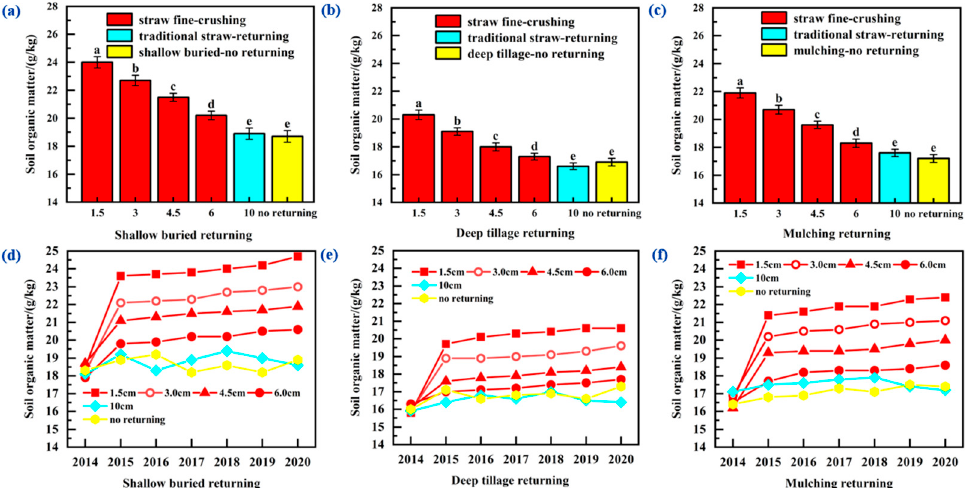
Figure 4. Six-year average of SOM shown in ( a – c ) and SOM values for each year shown in ( d – f ). Averages followed by different lowercase letters are significantly different according to LSD’s multiple-range experiment at the significance level of 0.05. Conversely, the same letters represent no significant difference ( p > 0.05). Error bars are standard deviation.